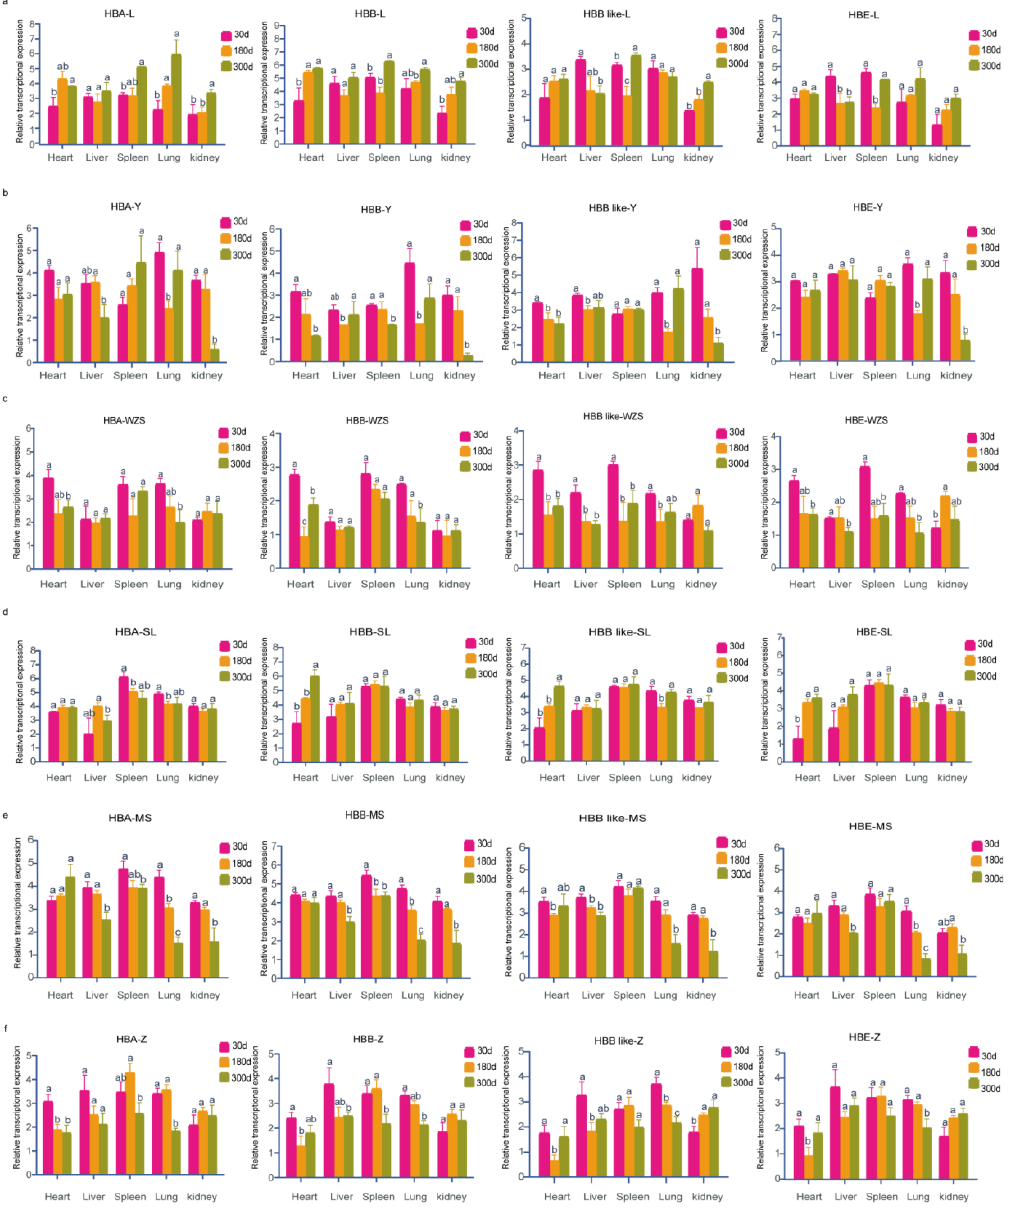
Figure 4. Expression patterns of hemoglobin-encoding genes in adult pig different tissues. ( a – f ) rep- resent expression of HBA , HBB , the HBB-like and HBE gene in Landrace (L), Yorkshire (Y),